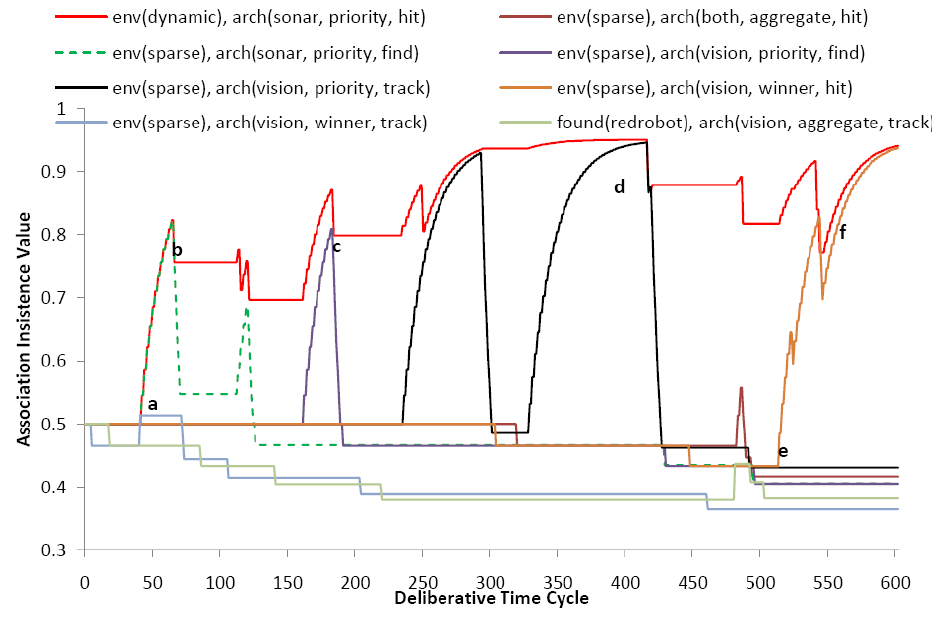
Figure 7. Variation in association insistence in the hit(redrobot) learning experiment.